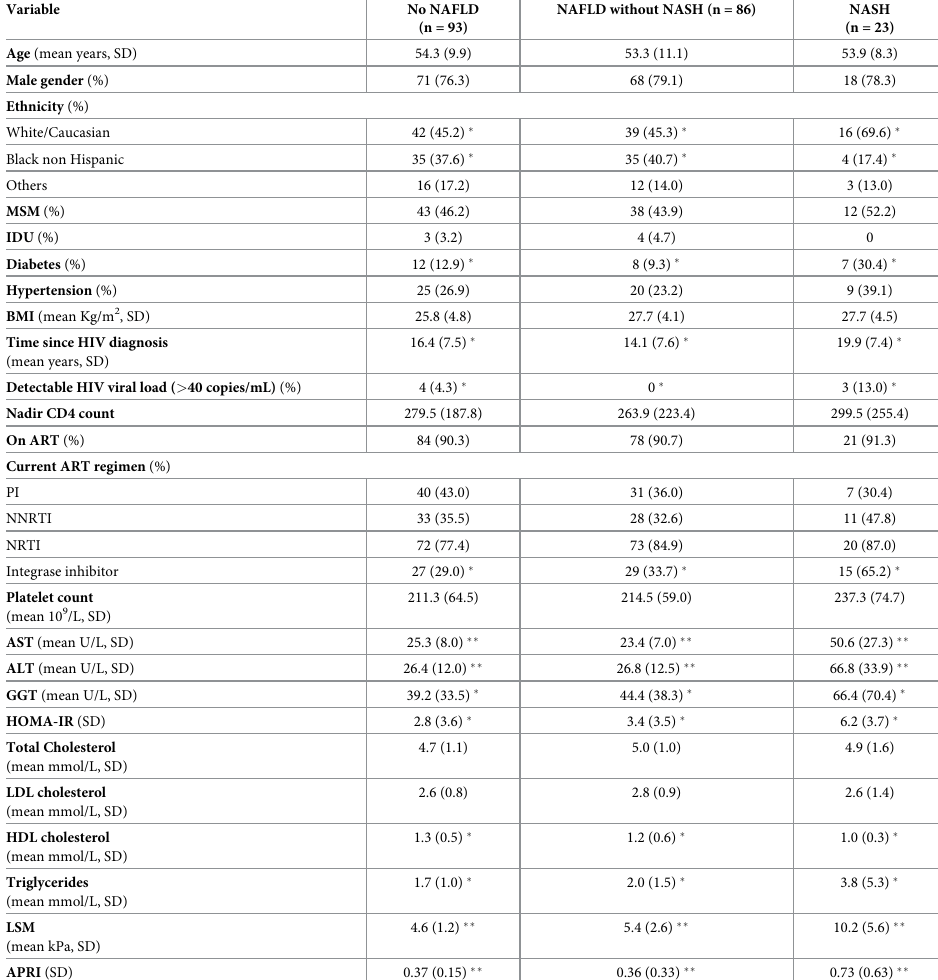
Table 1. Demographic, clinical, biochemical, and virological characteristics of 202 patients with HIV mono-infec- tion and univariate analysis by presence of NAFLD and